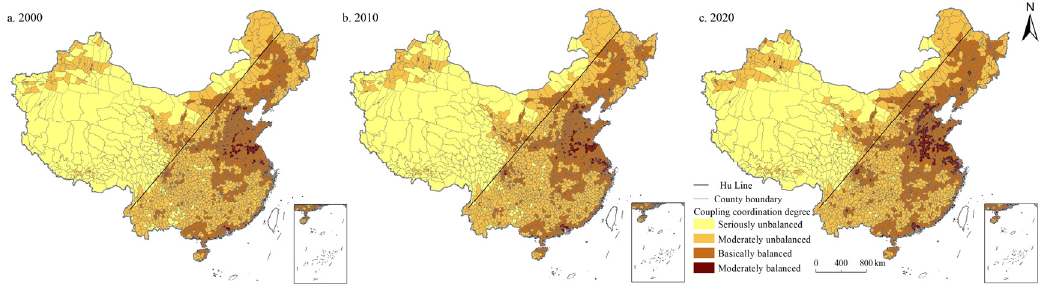
Figure 8. Spatial distribution of coordination degree of PLES in China during 2000–2020.